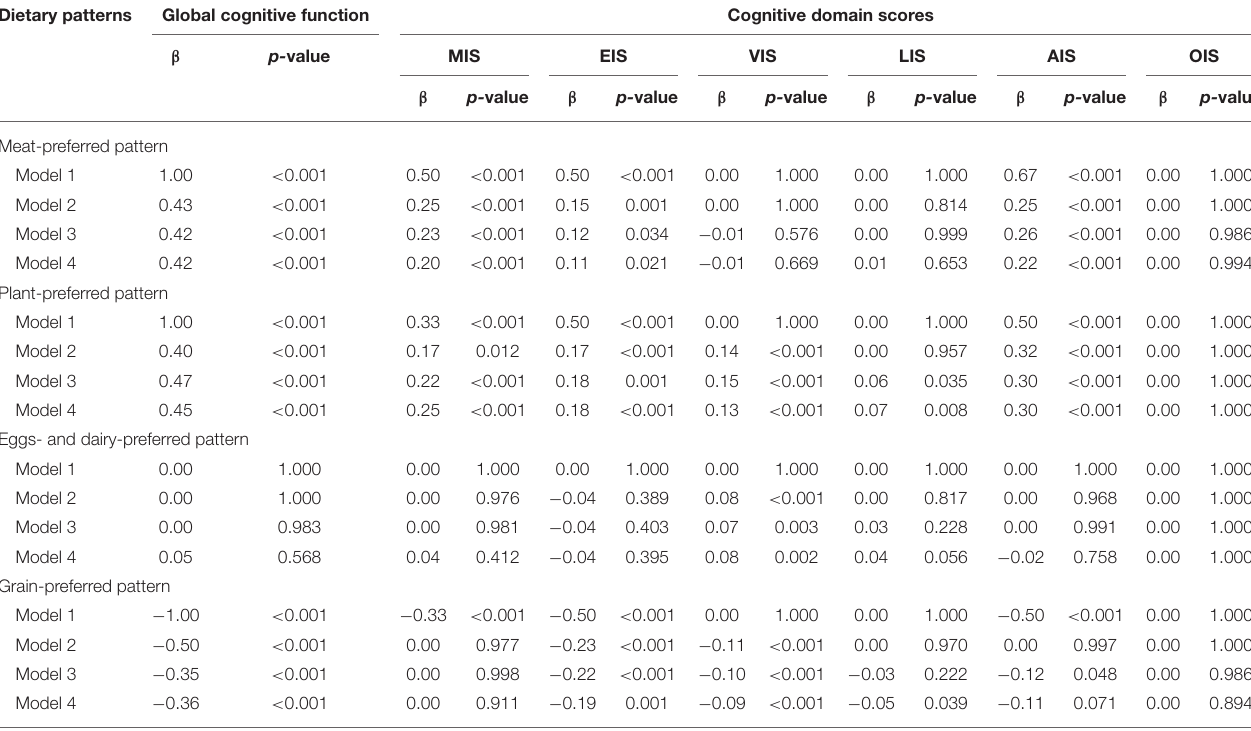
TABLE 4 | Quantile regression analysis of associations of four dietary pattern scores with global cognitive score and cognitive domain subscores a . Dietary patterns Global cognitive function Cognitive domain